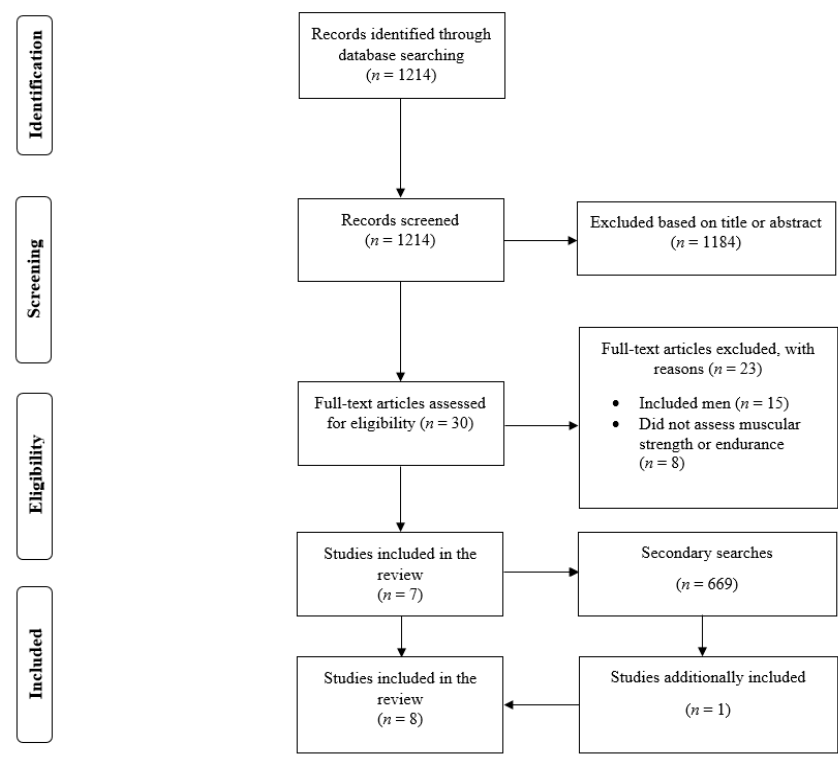
Figure 1. Flow diagram of the search process.